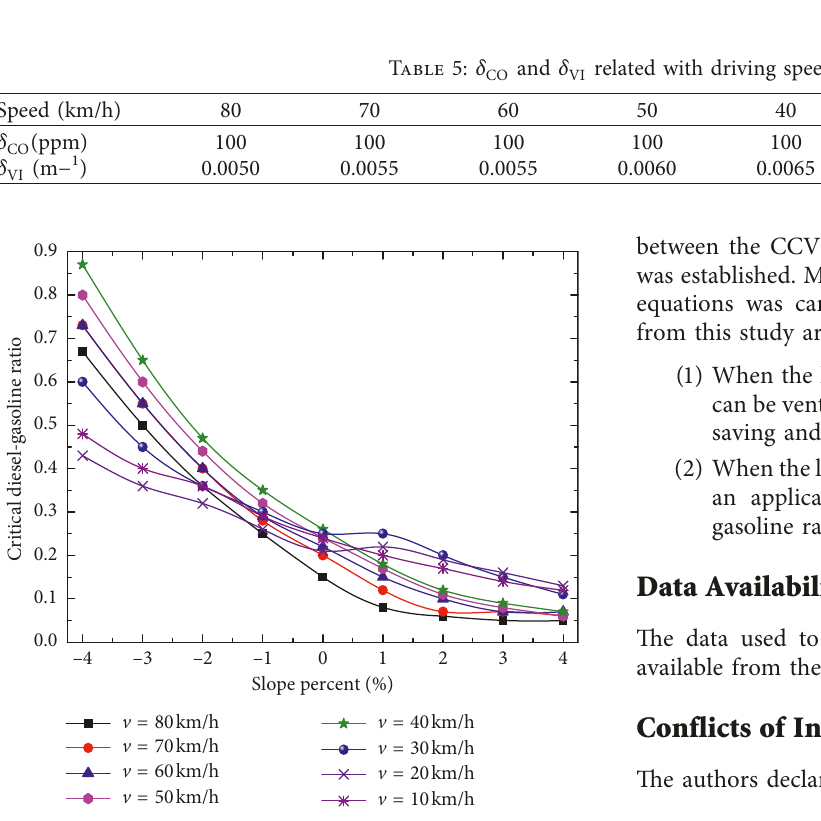
Figure 6: Critical diesel-gasoline ratio changing with slope and driving speed. “ v ” is notated with “driving